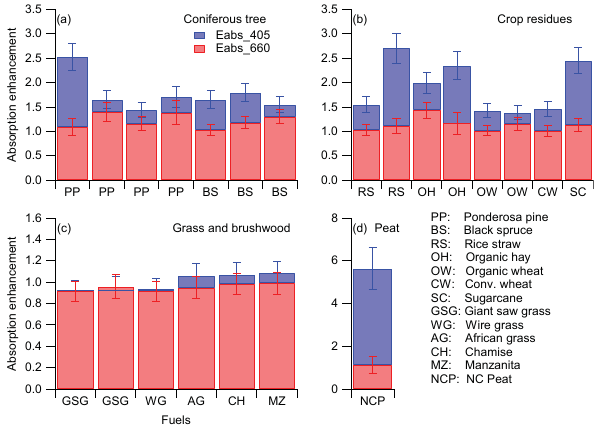
Figure 4. Bar plots of absorption enhancements derived by ther- mally denuding aerosol and measuring denuded and non-denuded particles at both 405 and 660nm. Results are grouped in terms of fuel types. Total bar heights (red + blue) are representative of ab- sorption enhancement at 405nm while red bars represent absorp- tion enhancement at 660nm. Panel (a) is for coniferous trees, (b) is for crop residues, (c) is for grass and brushwood, and (d) is for peat. The legend shows the name of each fuels reported in each